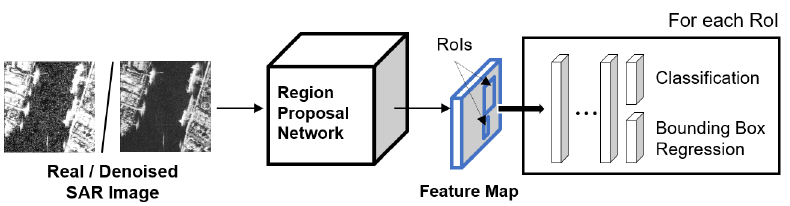
Figure 7. Overview of the traditional two-stage object detection network given a real or denoised (preprocessed) SAR image as